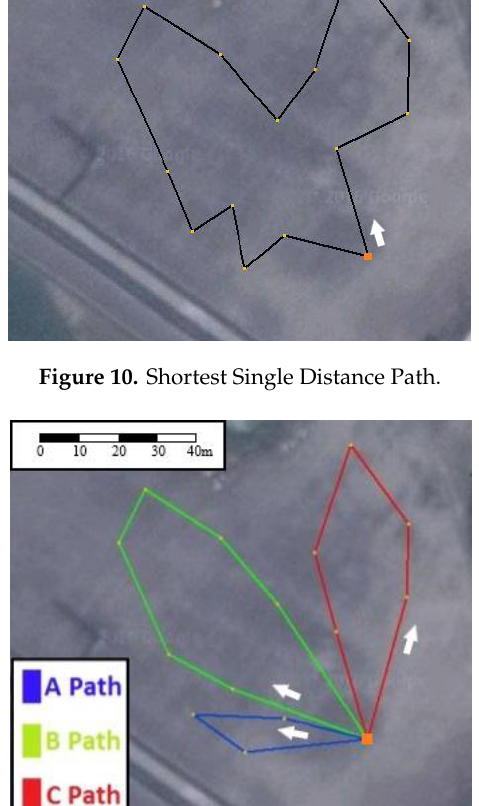
Figure 12. Experimental Trajectory When the Maximum Distance Limit Is 170 m.